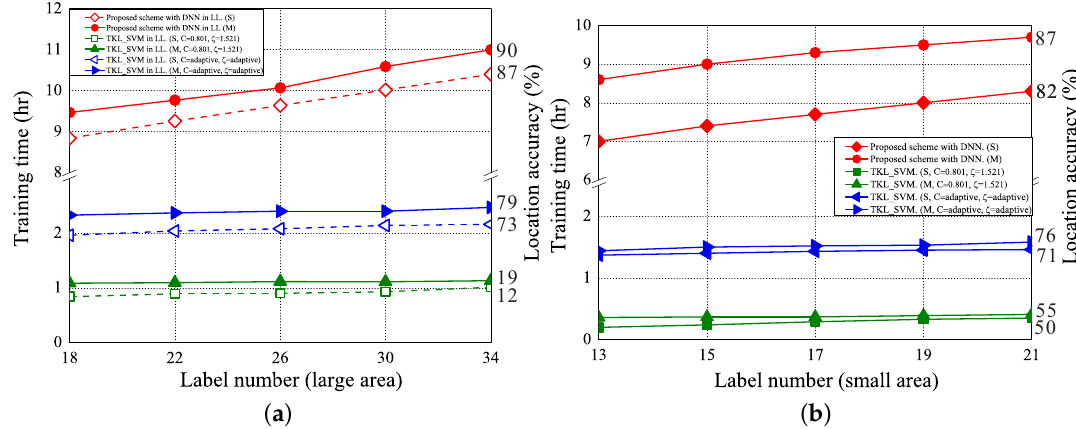
Figure 17. ( a ) The training time (LL,LS) vs. number of labelled samples; ( b ) the training time (SS) vs. number of labelled